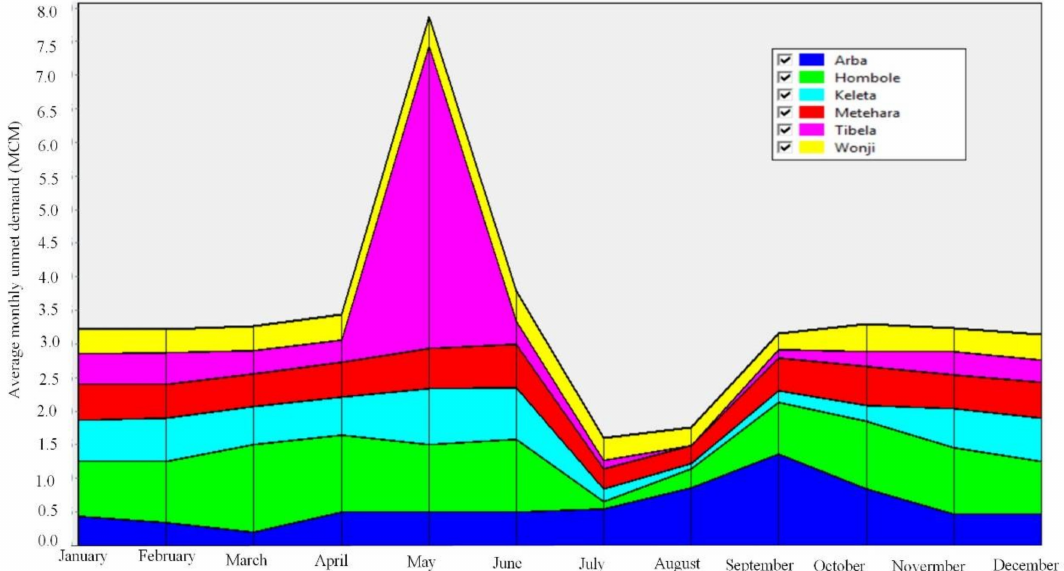
Figure 8. Mean monthly unmet demands of the current scenario for each irrigation